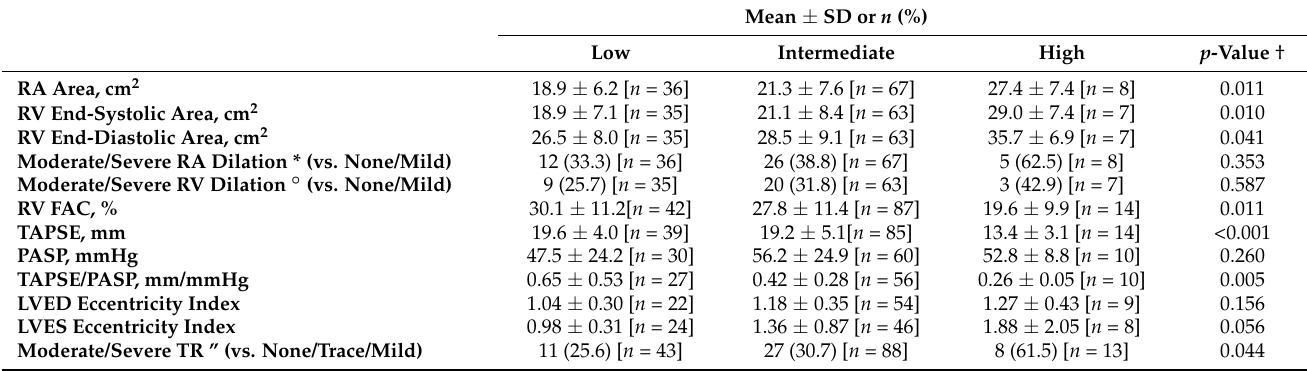
Table 3. Comparison of Echocardiographic Parameters between Risk